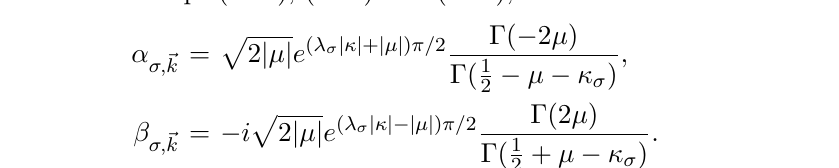
Figure 3 . E(cid:14)ciency of the particle production, j (cid:20) j (cid:0) j (cid:22) j , as a function of (cid:24) A and (cid:24) Z From the combination of eqs. (2.22), (3.11) and (3.12), we